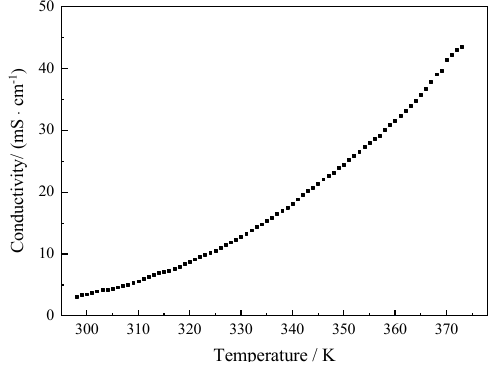
Figure 5. Electrical conductivity of [EMIm]F as a function of temperature.